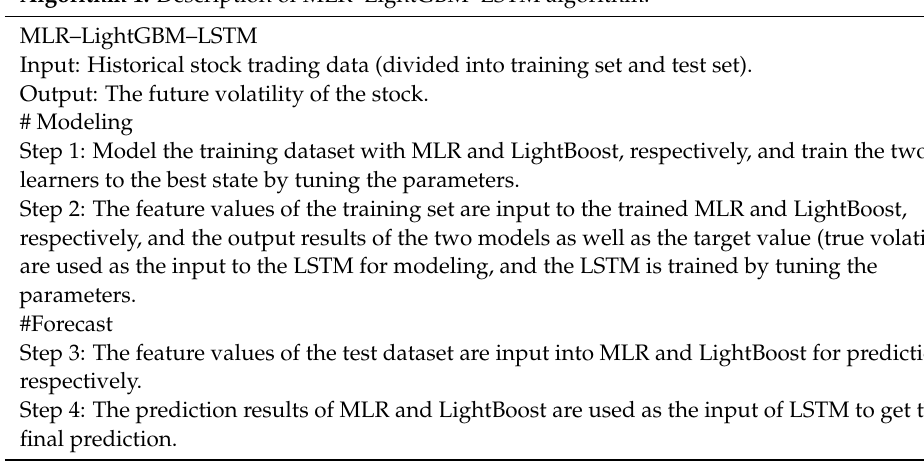
Figure 6. Architecture of MLR–LightGBM–LSTM model. Algorithm 1. Description of MLR–LightGBM–LSTM algorithm.